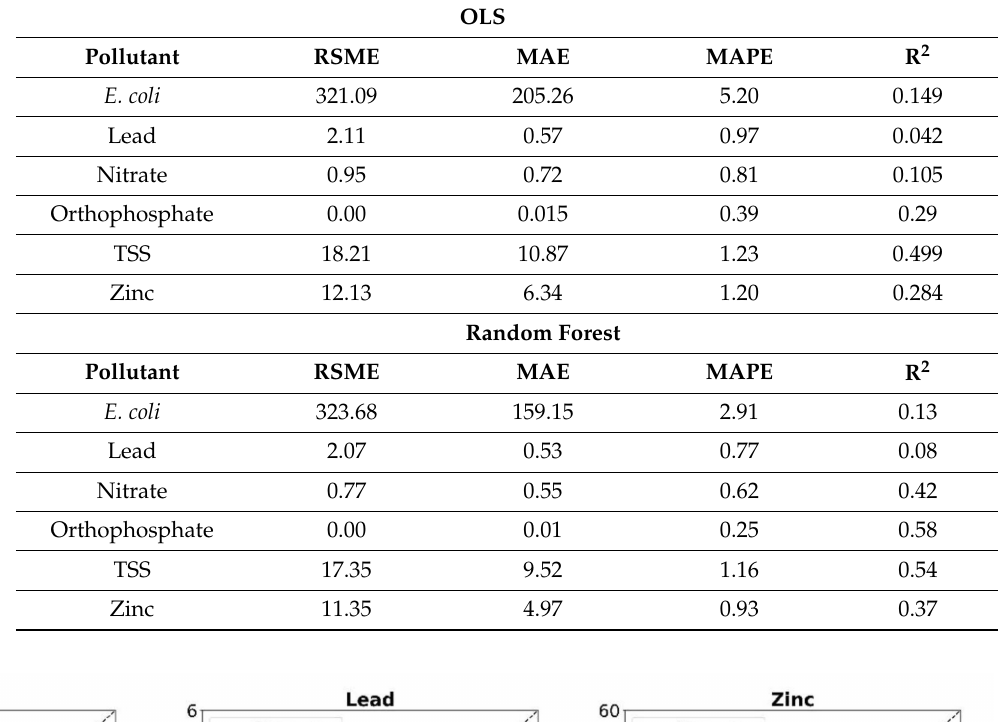
Table 3. Comparison of model goodness-of-fit between Random Forest and OLS.